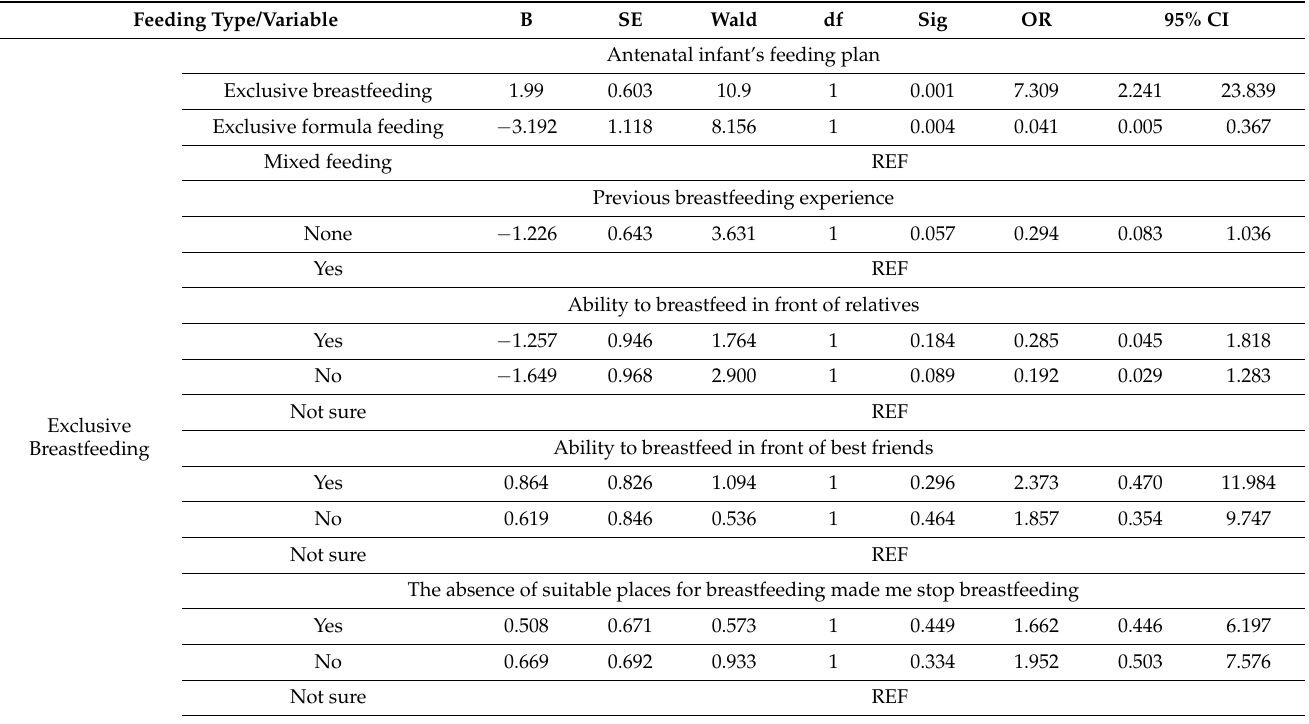
Table 4. Multinomial logistic regression analysis of factors associated with exclusive breastfeeding at the age of 6 months in